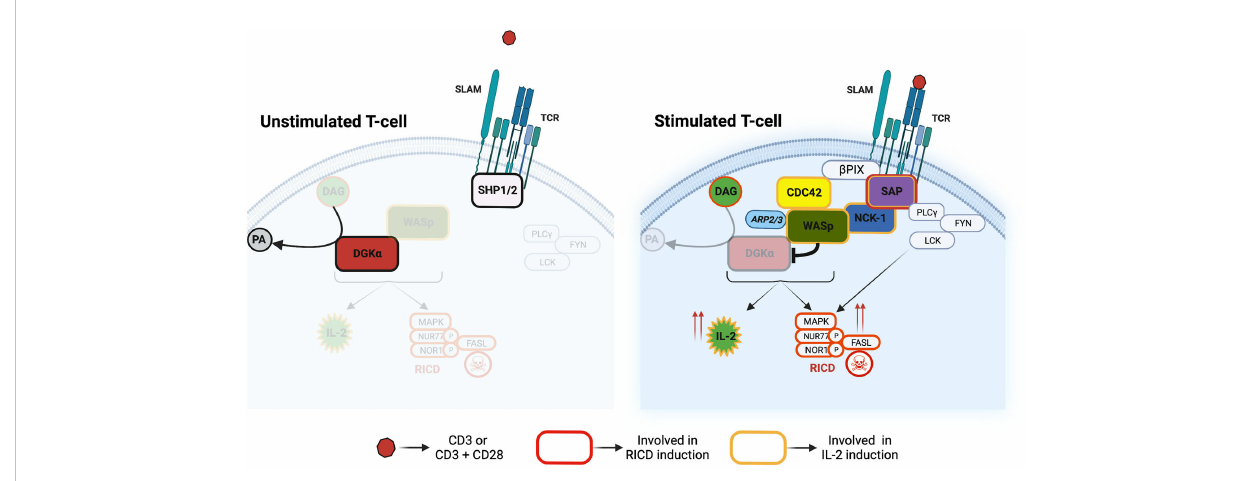
FIGURE 9 Divergent signalling pathways downstream to SAP The SAP-NCK-1/CDC42-WASp pathway controls DGK a activity and DAG cellular metabolism. This pathway tunes IL-2 and RICD responses in T cells. Other SAP interactors such as Lck and Fyn are crucial regulators of RICD